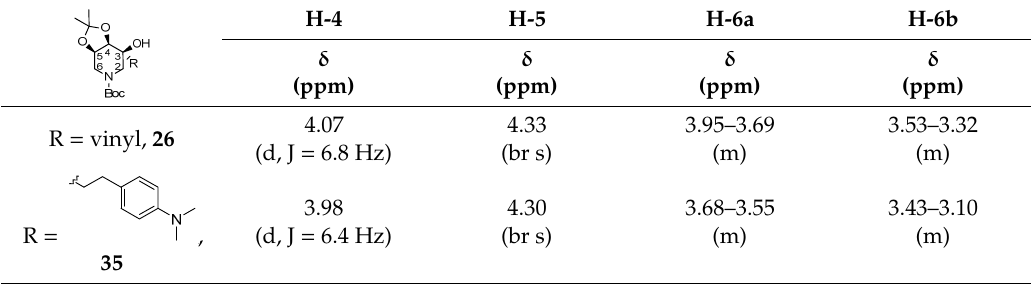
Table 2. Chemical shifts and coupling constants of H-4, H-5, and H-6 of protected compounds 26 and 35 , in CDCl 3 .